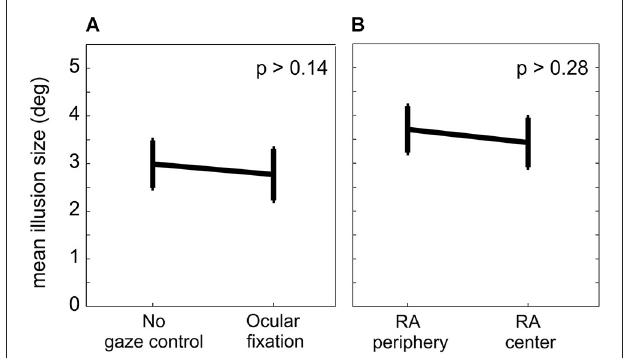
FIGURE 4 | Localization error in different conditions. (A) Mean localization error across 11 subjects and three different congruency conditions with (experiment I) and without (control experiment Ia) ocular fixation. There was no significant difference between the mislocalization error between the two fixation conditions. (B) Mean localization error across 10 subjects for two lateral positions of RA. There was no significant difference in the mislocalization error between the RA in the periphery (experiment II) and in the center (control experiment IIa). Error bars represent